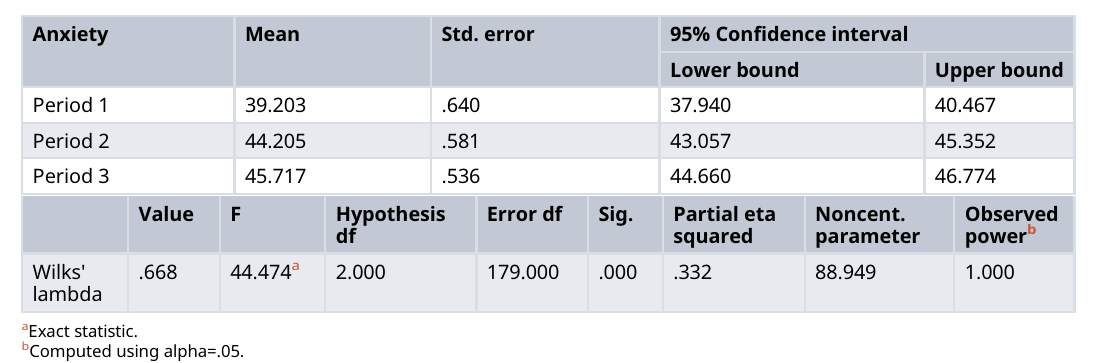
Table 3. F tests the multivariate effect of anxiety.